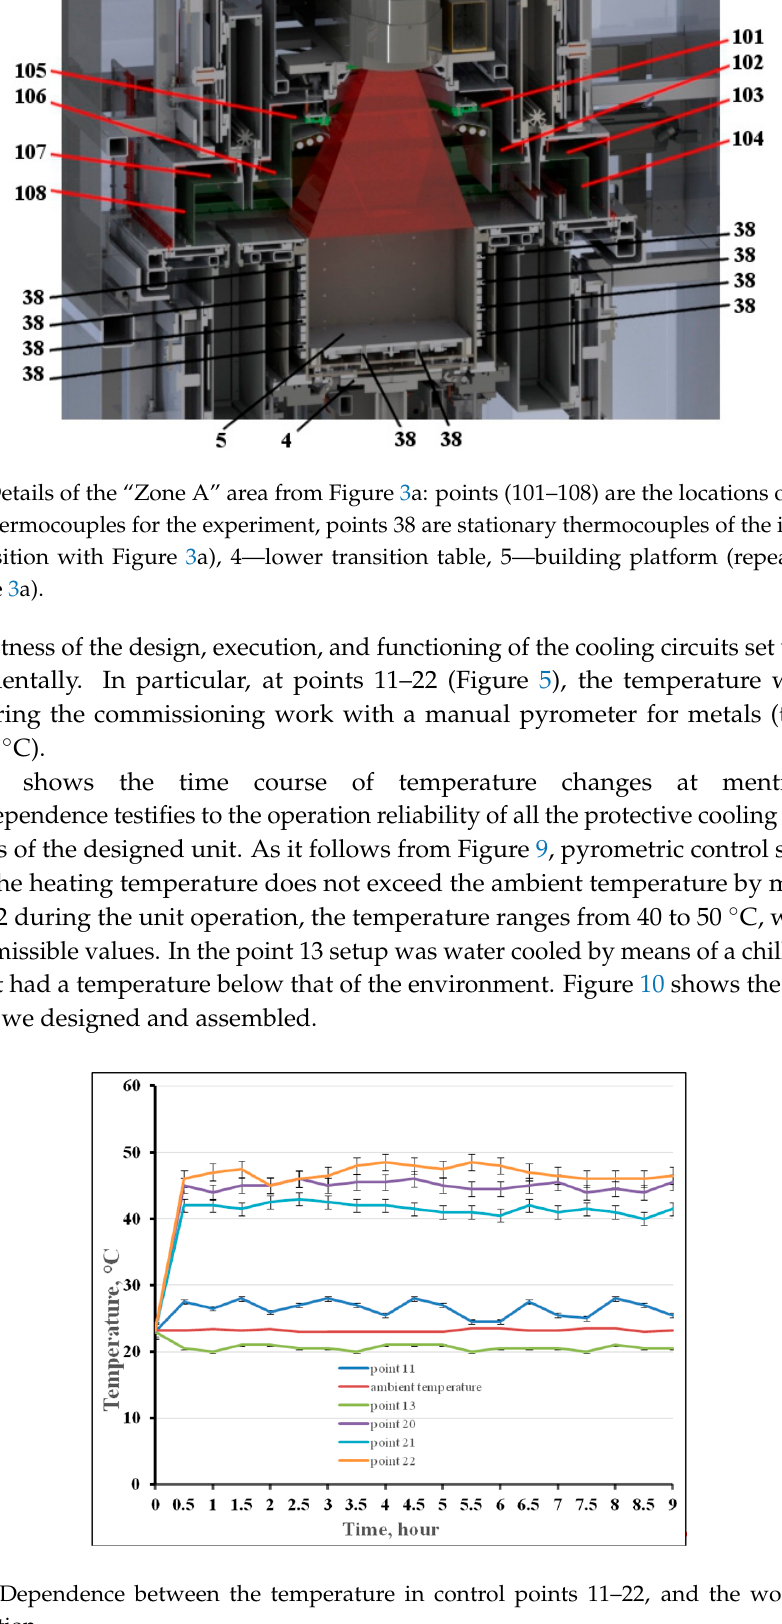
Figure 9. Dependence between the temperature in control points 11–22, and the work time of the installation.